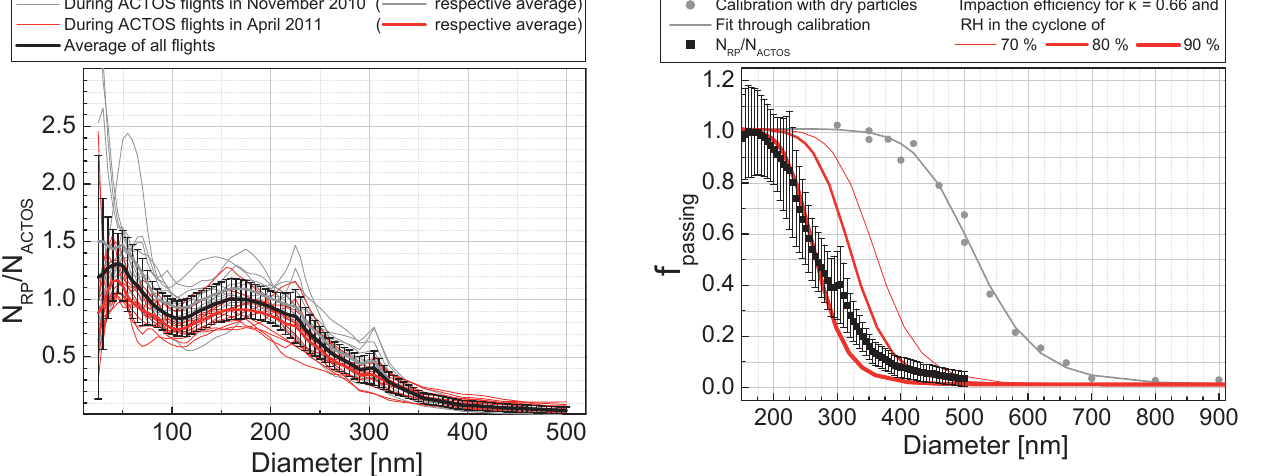
Figure A1. Bin-wise comparison of NSDs measured at Ragged Point and on ACTOS (i.e., N RP /N ACTOS ).